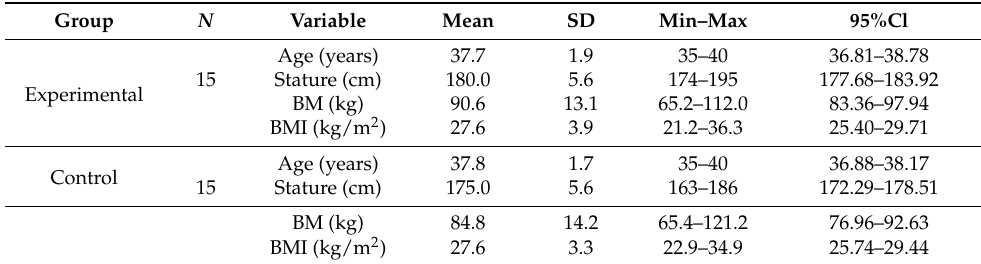
Table 1. Characterization of the study participants.